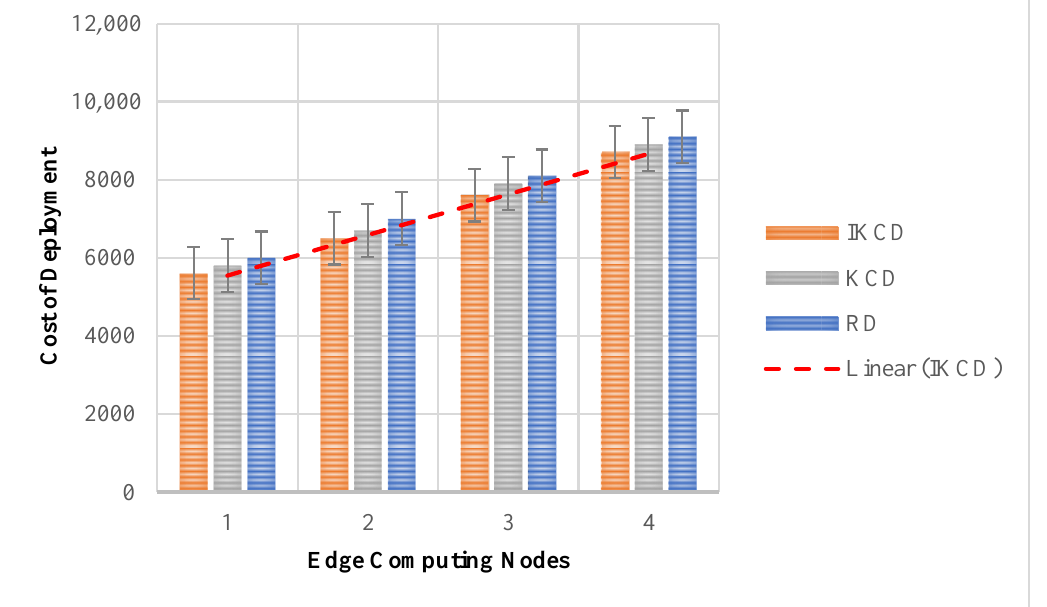
Figure 13. Cost dependency deployment on edge computing nodes. Figure 14 presents the relationship between system cost and edge computing nodes based on the compared